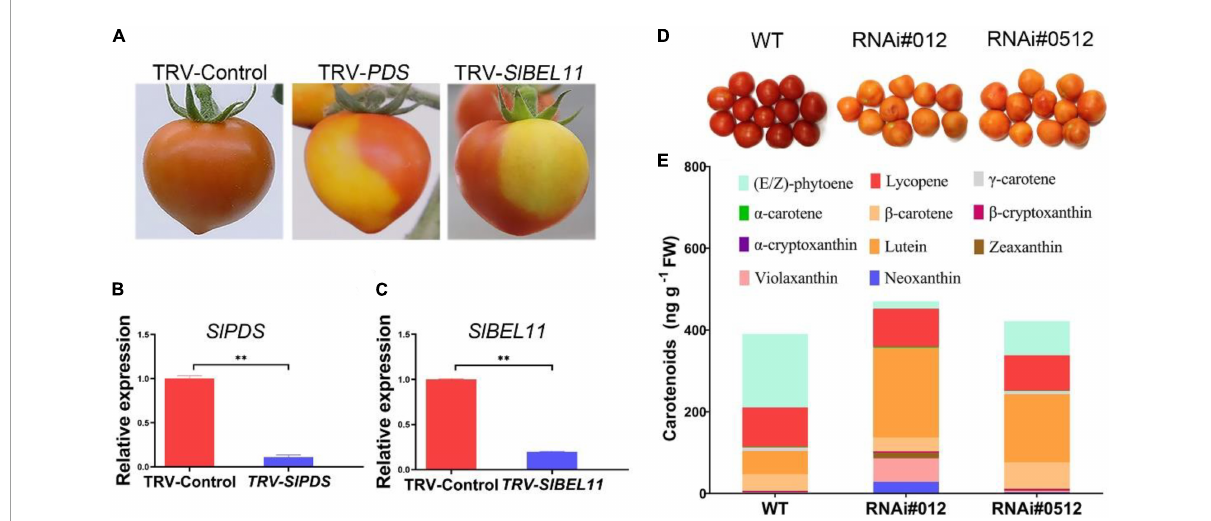
FIGURE1 Silencing of the SlBEL11 gene affects carotenoid accumulation in tomato fruits. (A) Ripe fruit of plants infected with empty vector virus (TRV-Control), specific fragment of SlPDS gene (TRV-SlPDS), and specific fragment of SlBEL11 gene (TRV- SlBEL11 ). (B) Analysis of qRT-PCR for SlPDS gene in tomato fruits in TRV-Control (red sections) and TRV- SlPDS group (yellow sections). (C) qRT-PCR analysis for SlBEL11 gene in tomato fruits in TRV-Control (red sections) and TRV- SlBEL11 group (yellow sections). The internal reference was actin gene. The results were presented mean ± standard deviation (SD) of three independent replicates. **Indicated a P -value < 0.01 (Student’s t -test). (D) Tomato fruit phenotype of SlBEL11 RNAi and wild type (WT) at the red stage. The stage of tomato was defined by external and internal color of the tomato fruit. For the mature green stage, fruits will ripen to an acceptable level of horticultural quality. The entire surface of the fruits was either green or white, with no visible red. At the red stage, there was more than 90% of the surface showing red color. (E) Carotenoids content in SlBEL11 RNAi and WT tomato fruits determined at 5 days after breaker (Br + 5) stage.